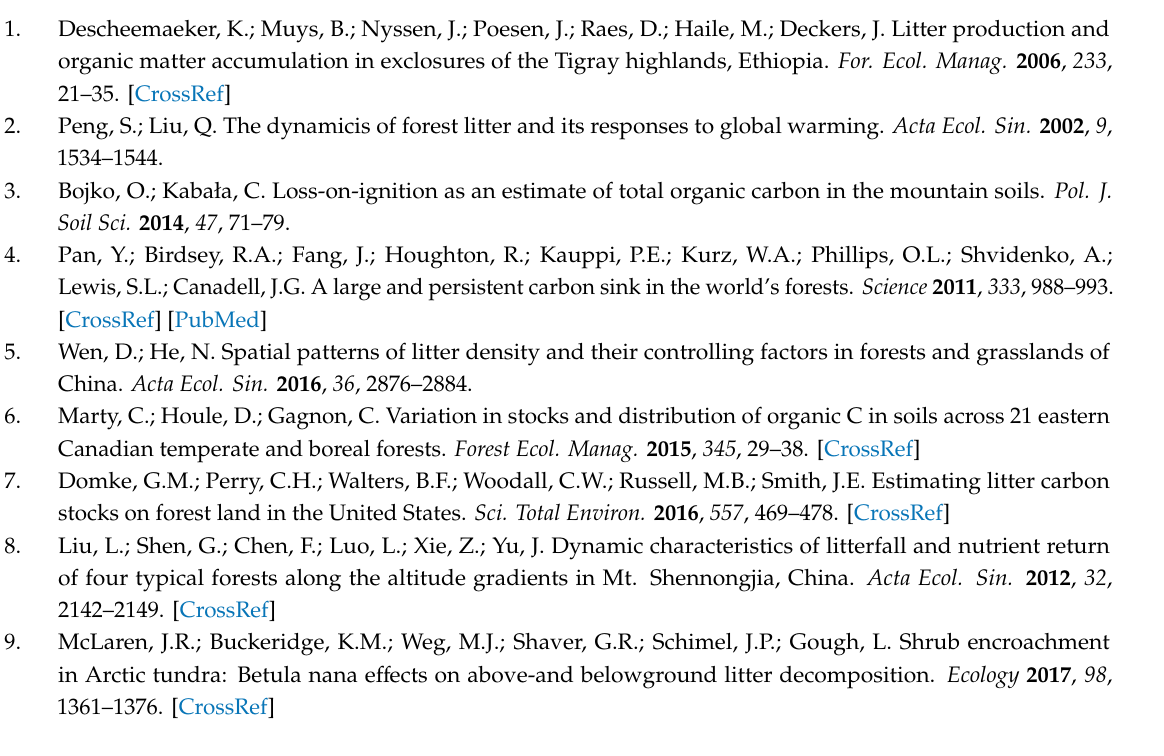
Figure S1: Relationships among aboveground biomass, litter standing crop carbon, and climatic factors, (a) mean annual temperature (MAT), (b) mean annual precipitation (MAP); Figure S2: Relationships among longitude, (a) mean annual precipitation (MAP), (b) mean annual temperature